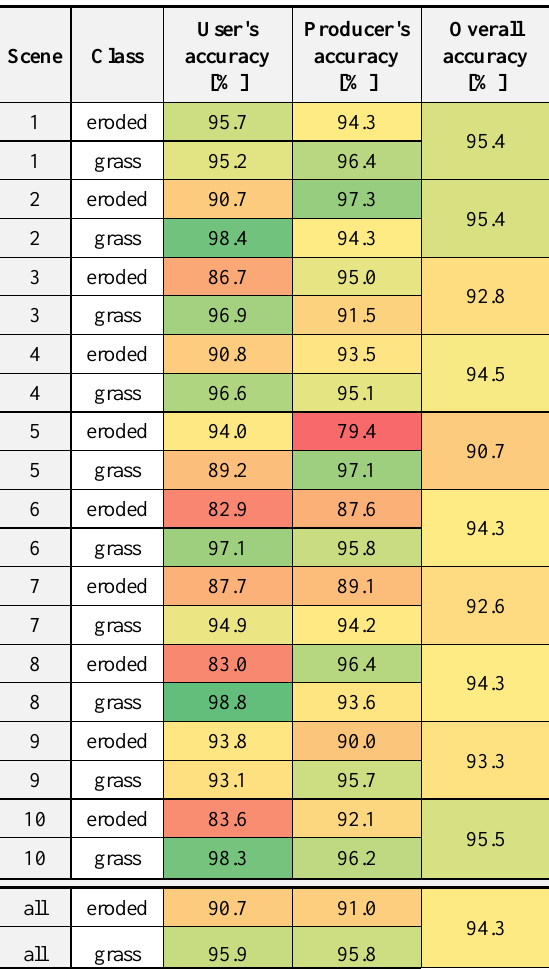
Table 3: Accuracy of the classification results compared to a manual classification of eroded areas and grass with the same data. Colour ramp: red (low accuracy) – yellow – green (high